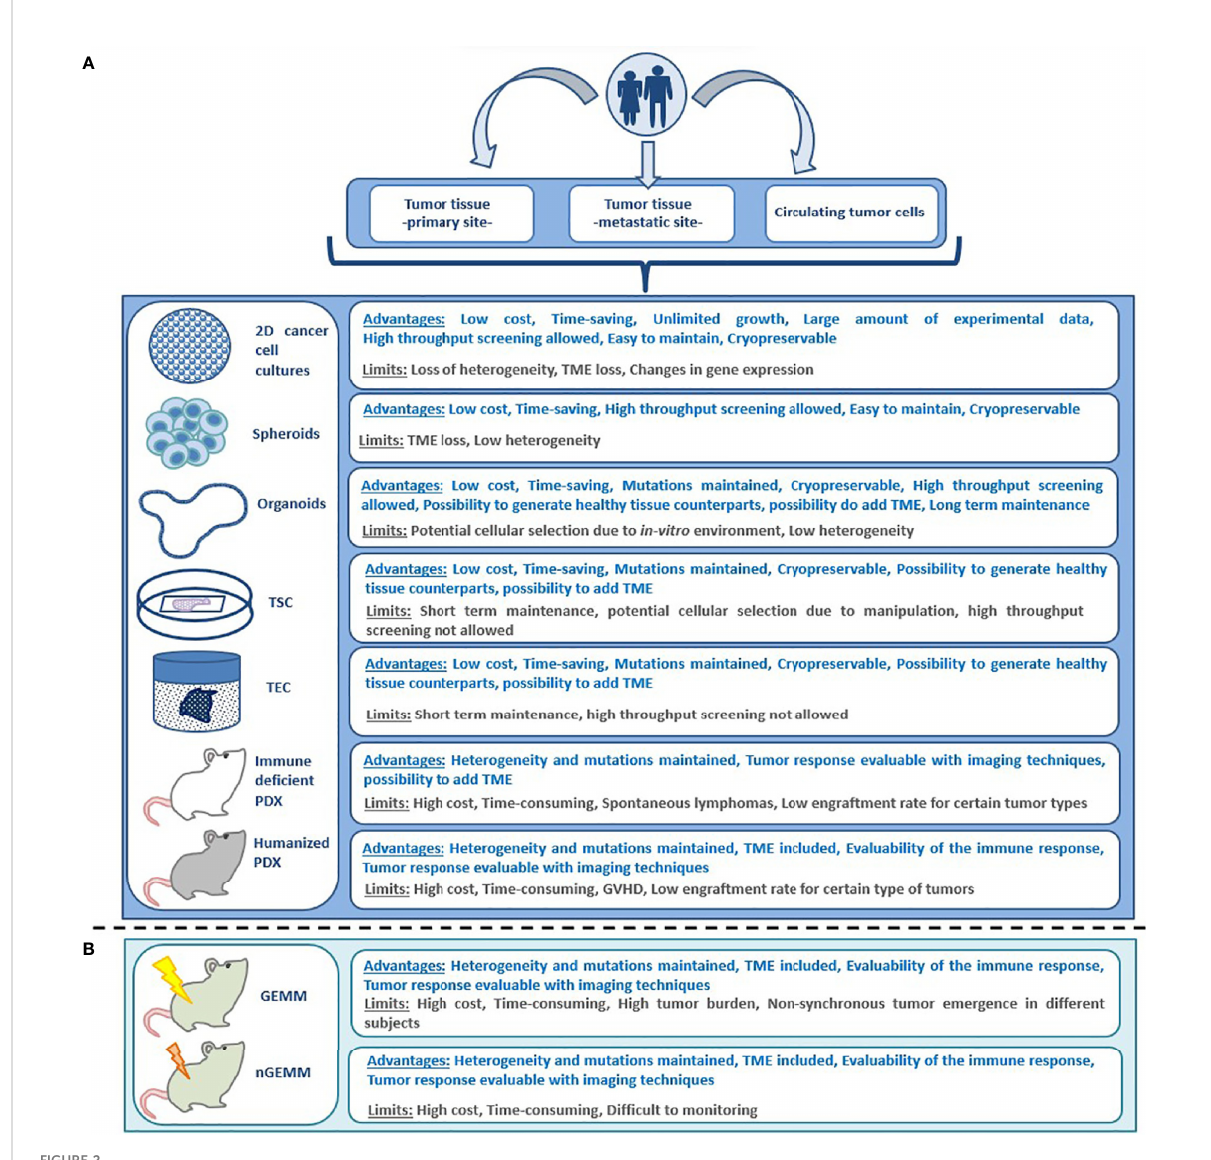
FIGURE 2 Advantages and limitations of different preclinical models for anticancer drug testing; (A) patient derived models, (B) non patient-derived animal models. GEMM, genetically engineered mouse model; GVHD, graft versus host disease; nGEMM, non-germinal genetically engineered mouse model; PDX, patient-derived xenograft; TEC, tumor explant culture; TME, tumor microenvironment; 2D, bi-dimensional; TSC, tumor slice